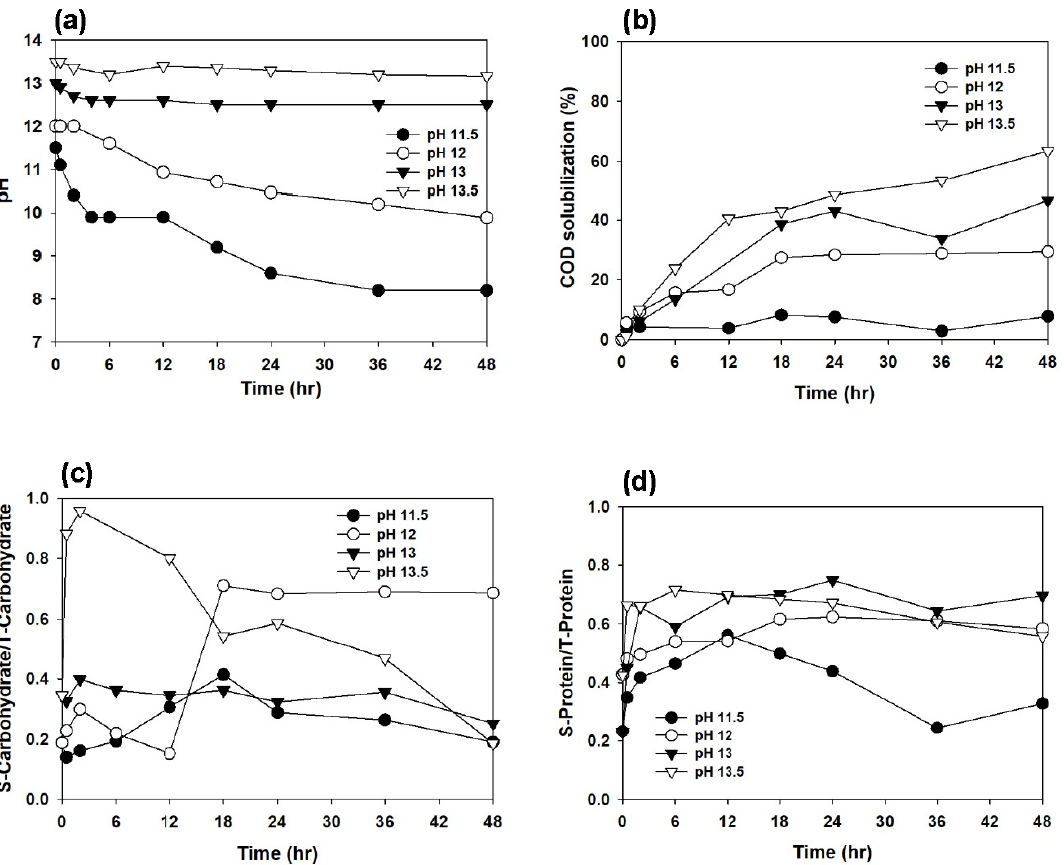
Figure 1. Solubilization of sewage sludge: ( a ) pH variation, ( b ) COD solubilization, ( c ) soluble carbohydrate/total carbohydrate, and ( d ) soluble protein/total protein.